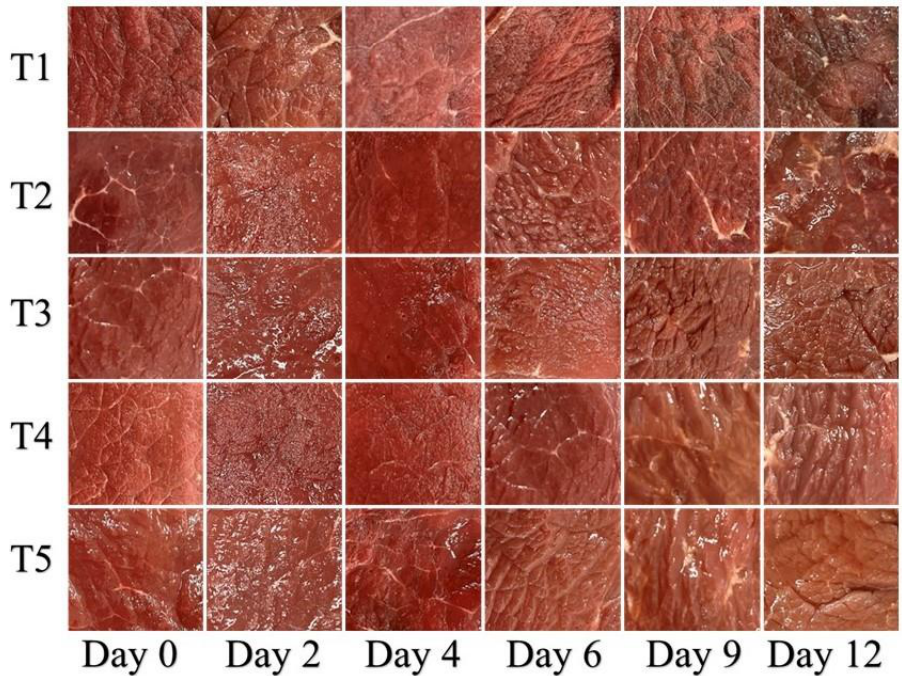
Figure 1. Images of beef samples from different treatment groups during storage. T1: Control, beef samples immersed in distilled water; T2: Beef samples treated with GEL-CHI-GLY edible coating; T3: Beef samples treated with GEL-CHI-GLY-CA edible coating; T4: Beef samples treated with GEL- CHI-GLY-GA edible coating; and T5: Beef samples treated with GEL-CHI-GLY-RES edible